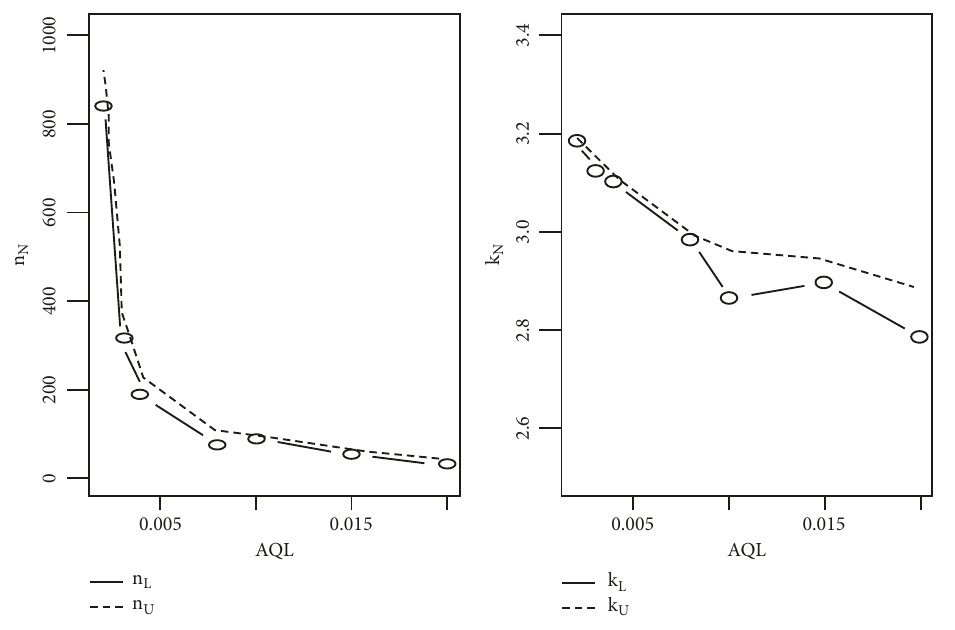
Figure 1: Trend in 𝑛 𝑁 𝜖{𝑛 𝐿 , 𝑛 𝑈 } and 𝑘 𝑁𝑎 𝜖{𝑘 𝐿𝑎 ,𝑘 𝑈𝑎 } when 𝛼 = 0.05 , 𝛽 =0.05, 𝑟 =2.